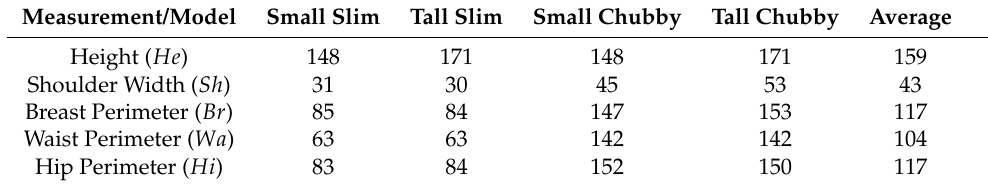
Table 3. Tailor measurements Me in cm for the Reference Mannequins RM , Me i ∈ RM .